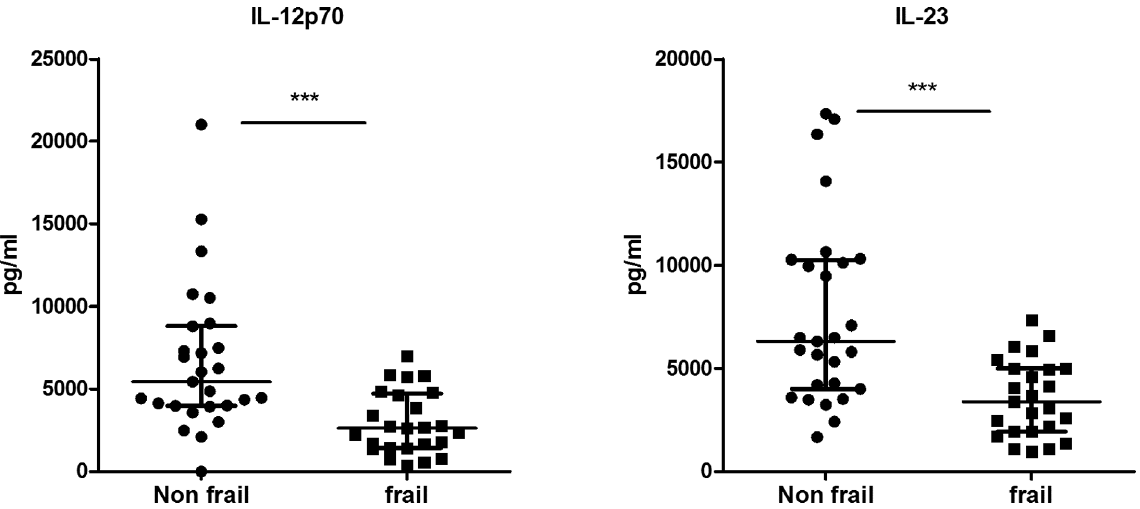
Figure 1. Decreased production of IL-12p70 and IL-23 in response to LPS + R848 stimulation in frail old individuals. Whole blood cells from frail (n=10) and non frail (n=9) old individuals were stimulated with LPS + R848 during 18 h. IL-12p70 and IL-23 were measured in cell-free supernatants by ELISA. Each dot represents a single donor and the bars represent median values 6 interquartile range. ***p , 0.001.